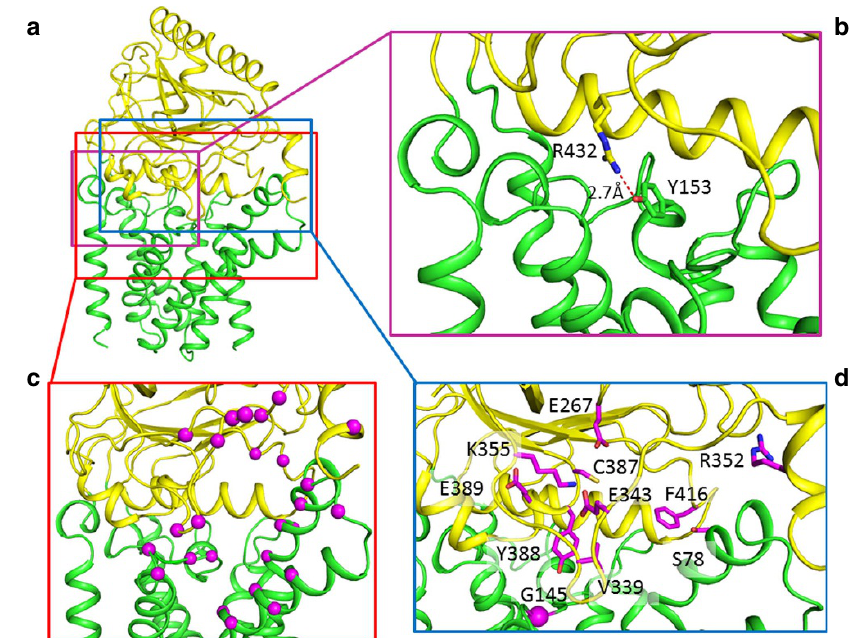
Figure 3 | Distribution of mutations sites in the three-dimensional structure of Lnt. ( a ) Overall structure of Lnt. The peptide backbone is shown as a tube model, with the TM and Nit domains being shown in green and yellow, respectively. ( b ) The interface between the Nit and TM domains. ( c ) Positions where a single Ala-mutation allows Lnt to maintain its activity are shown as magenta spheres. ( d ) Sidechains of residues for which a single Ala-mutation renders Lnt inactive are shown in stick models (Gly as a sphere) and coloured in